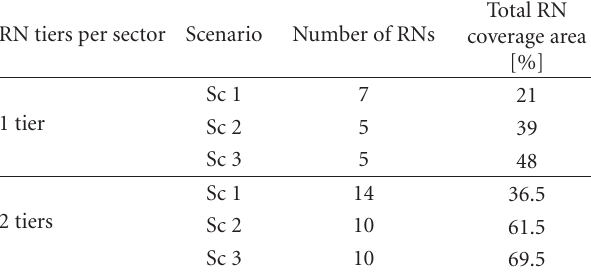
Table 4: RN Deployment Characteristics, ISD 1732